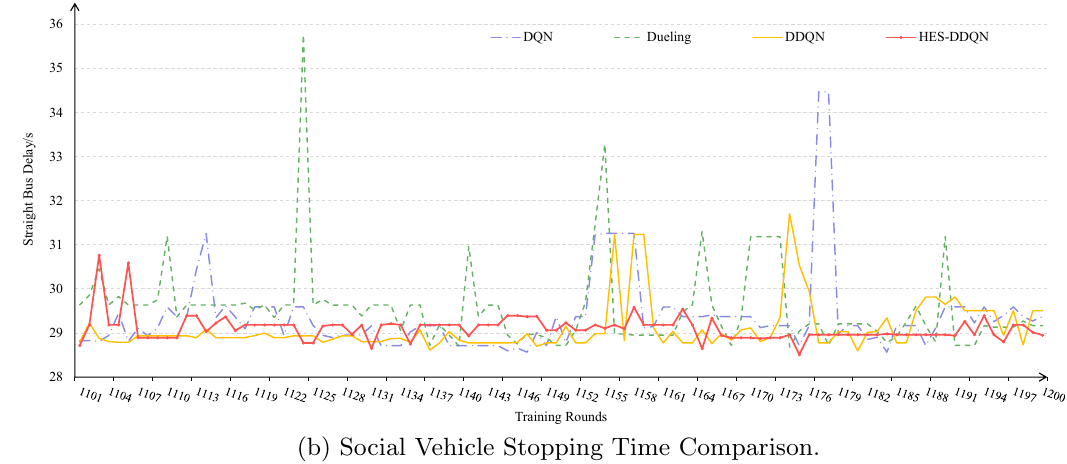
(b) Social Vehicle Stopping Time Comparison.